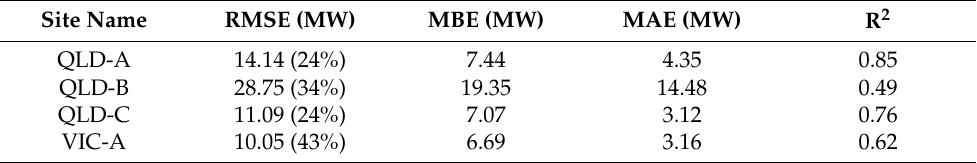
Table 7. Error metrics for predicted mean power ensemble at advection of 5